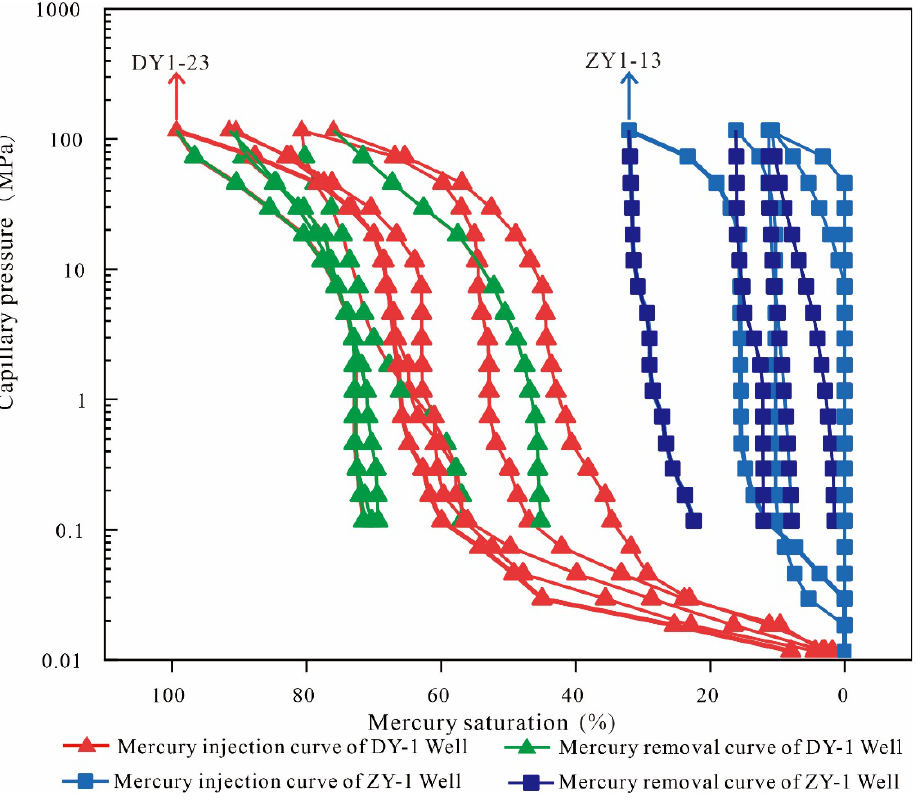
Figure 6. Capillary pressure curves of the Wufeng-Longmaxi Formation and Niutitang Formation shales in northern Guizhou Province based on high-pressure mercury intrusion.